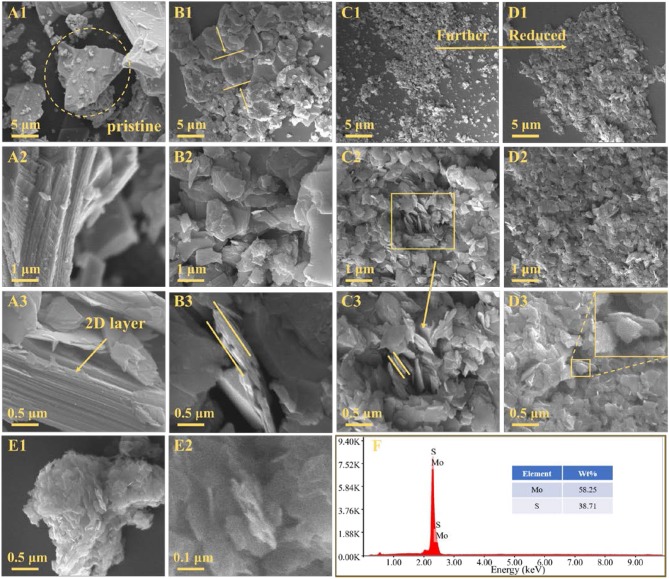
SEM images of (A1–A3) molybdenite concentrate, (B1–B3) MoS2-5 μm, (C1–C3) MoS2-2 μm, (D1–D3) MoS2-1 μm and (E1, E2) MoS2-90 nm. (F) Energy-dispersive spectrometry (EDS) of molybdenite concentrate.